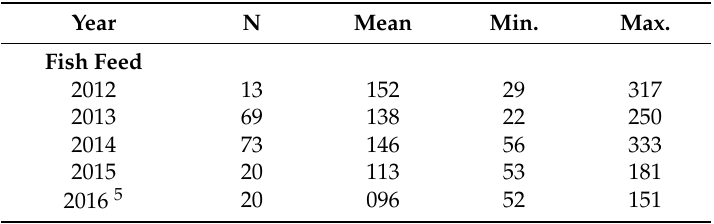
Table 2. Concentration of erucic acid (22:1n-9), given as mg fatty acid/100 g sample, in fish feed. The table shows the number of samples (N) for each year, the mean value of erucic acid, as well as the minimum and maximum